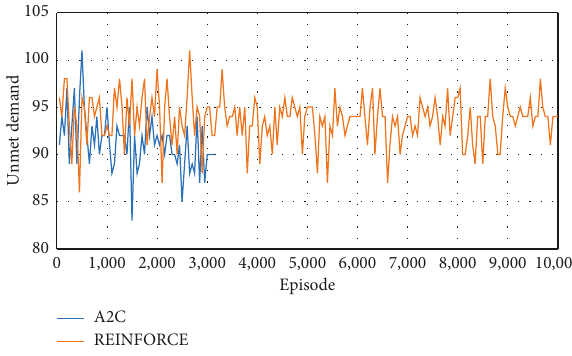
Figure 1: Performance analysis by reinforcement learning